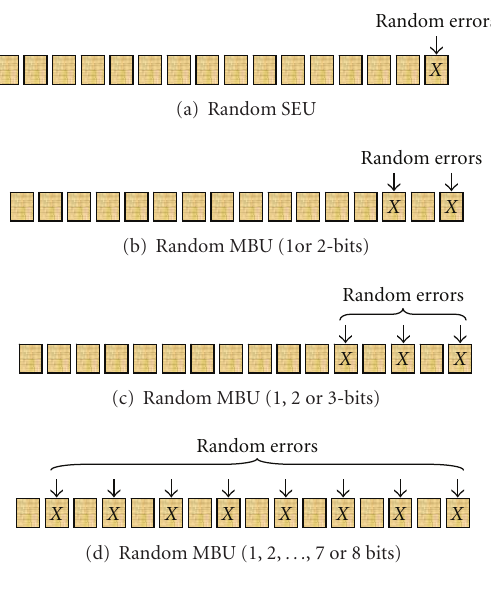
Figure 20: Error patterns for fault injection.